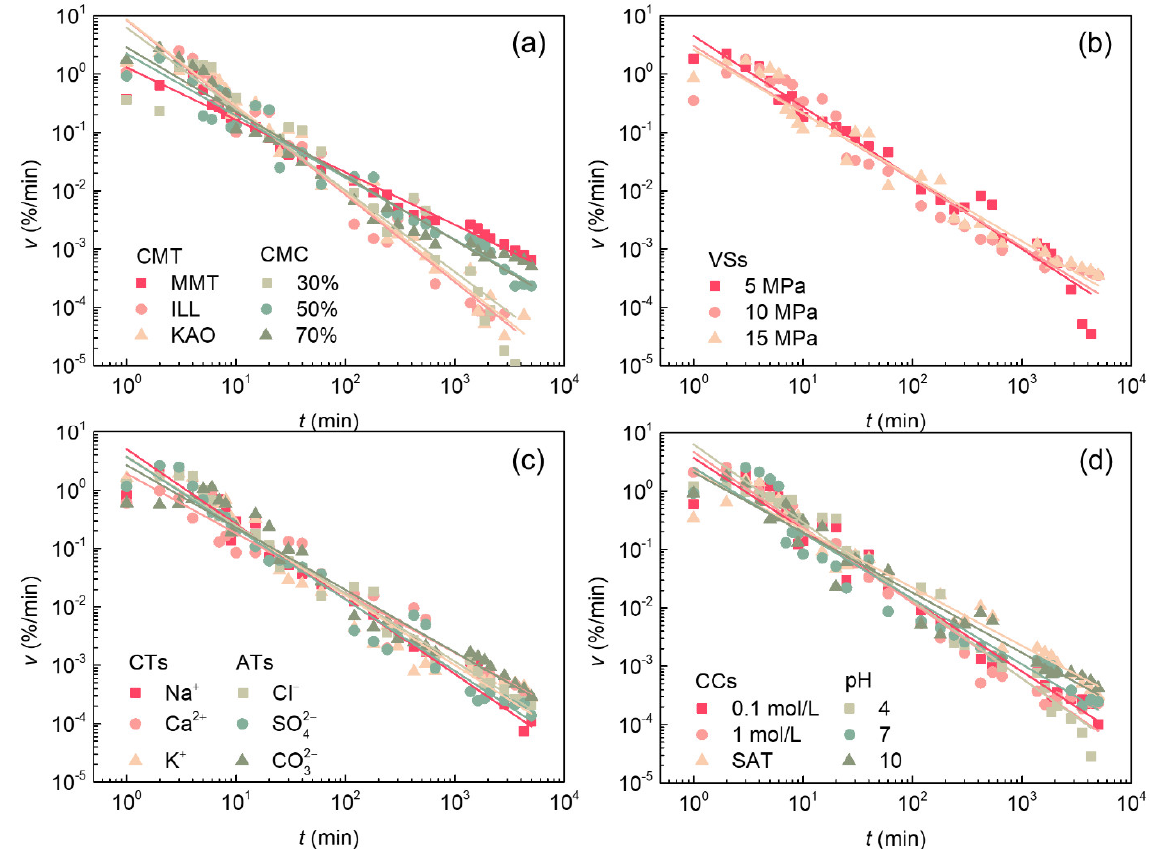
Figure 7. Water absorption velocity v with time t as affected by: ( a ) clay mineral type (CMT) and clay mineral content (CMT), ( b ) vertical stress (VSs), ( c ) cation type (CTs) and anion type (ATs) and ( d ) concentration (CCs) and pH value (pH).